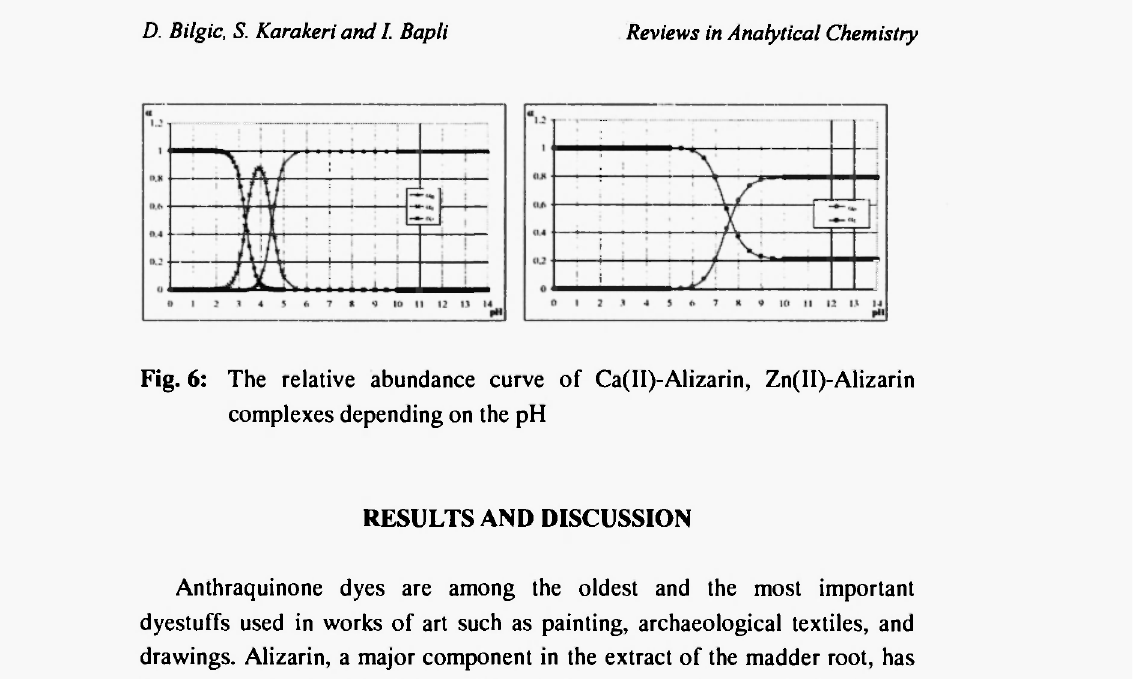
Fig. 6: The relative abundance curve of Ca(II)-Alizarin, Zn(II)-Alizarin complexes depending on the